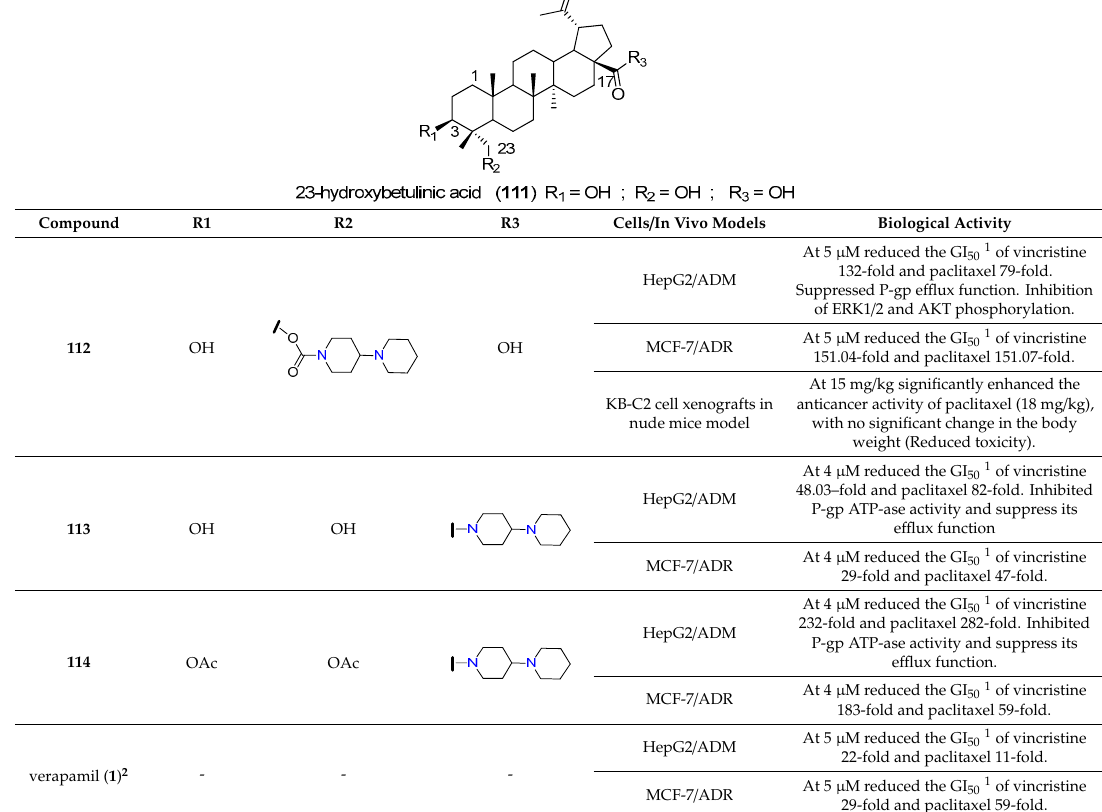
Table 13. P-gp-resistance reversal properties of triterpene derivatives 112 – 114 [131,132].